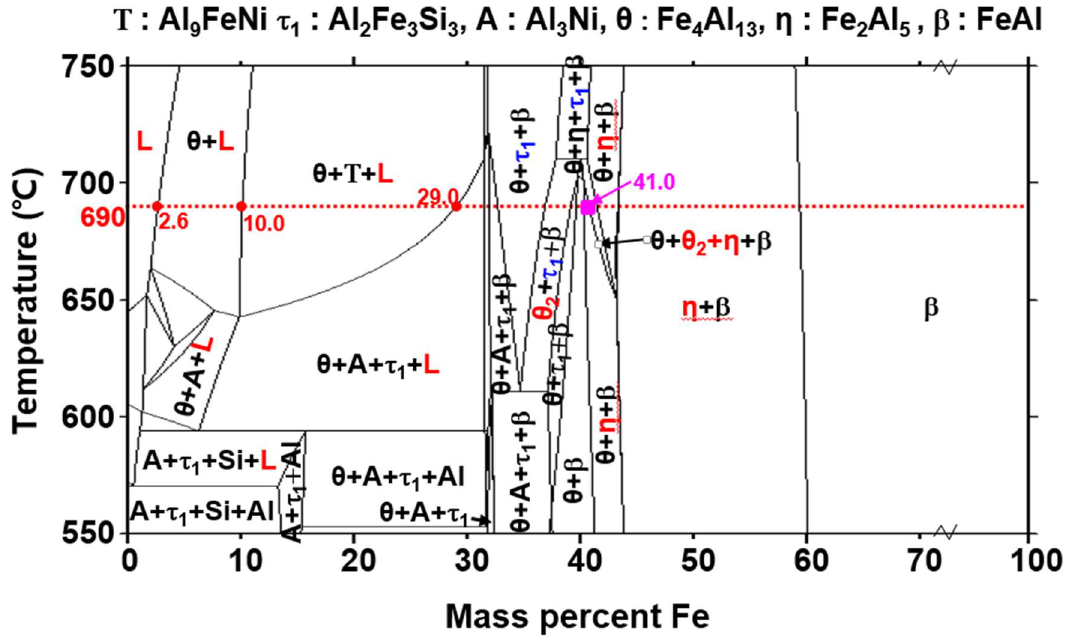
Figure 12. (Al-7wt%Ni-6wt%Si)-xFe pseudo-binary phase diagram obtained using Thermo-Calc TM software.